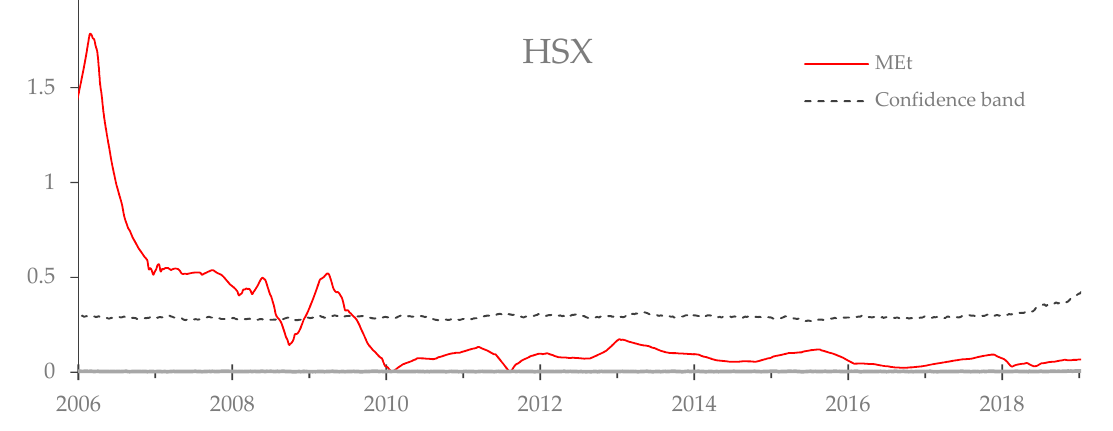
Figure 9. The time-varying autoregressive (TV-AR) result in HSX.